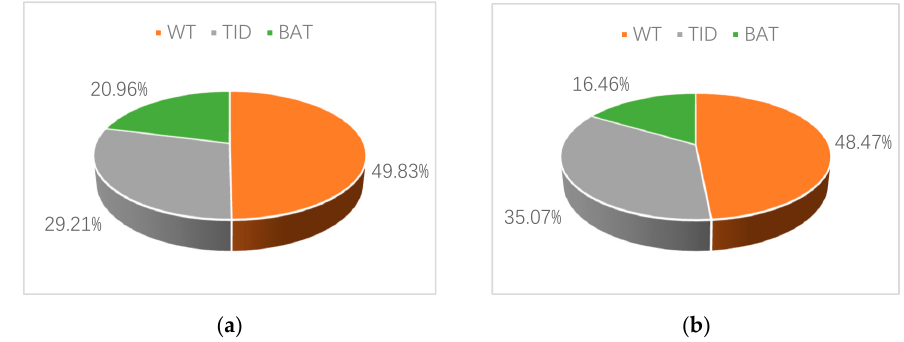
Figure 17. ( a ) The generation percentages; ( b ) The investment percentages.